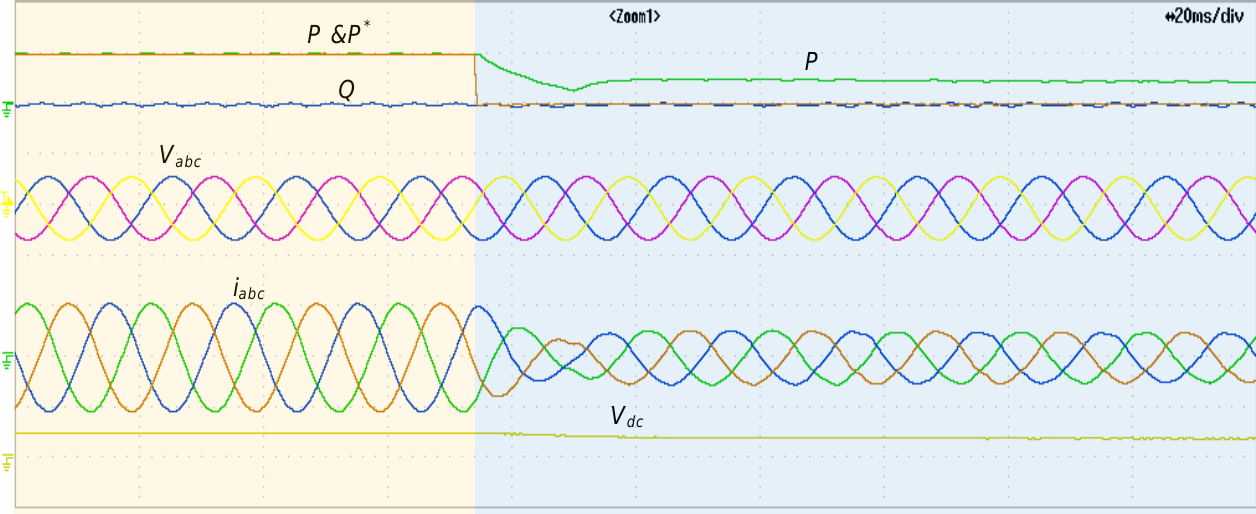
Figure 13. Real-time simulator results: active power reference step-down for BES-P2G. From top: active power reference ( P* , 10 kW/div), active power ( P , 10 kW/div), reactive power ( Q , 10 kVAR/div), grid voltage ( V abc , 1000 V/div), grid current